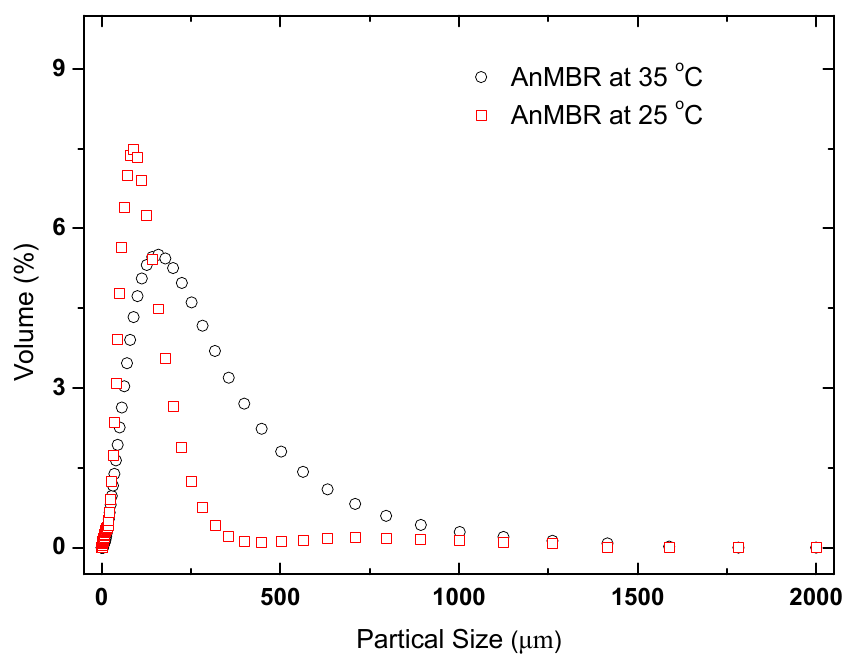
Figure 5. The particle size distribution (PSD) of sludge flocs in the two AnMBRs at 35 and 25 °C.